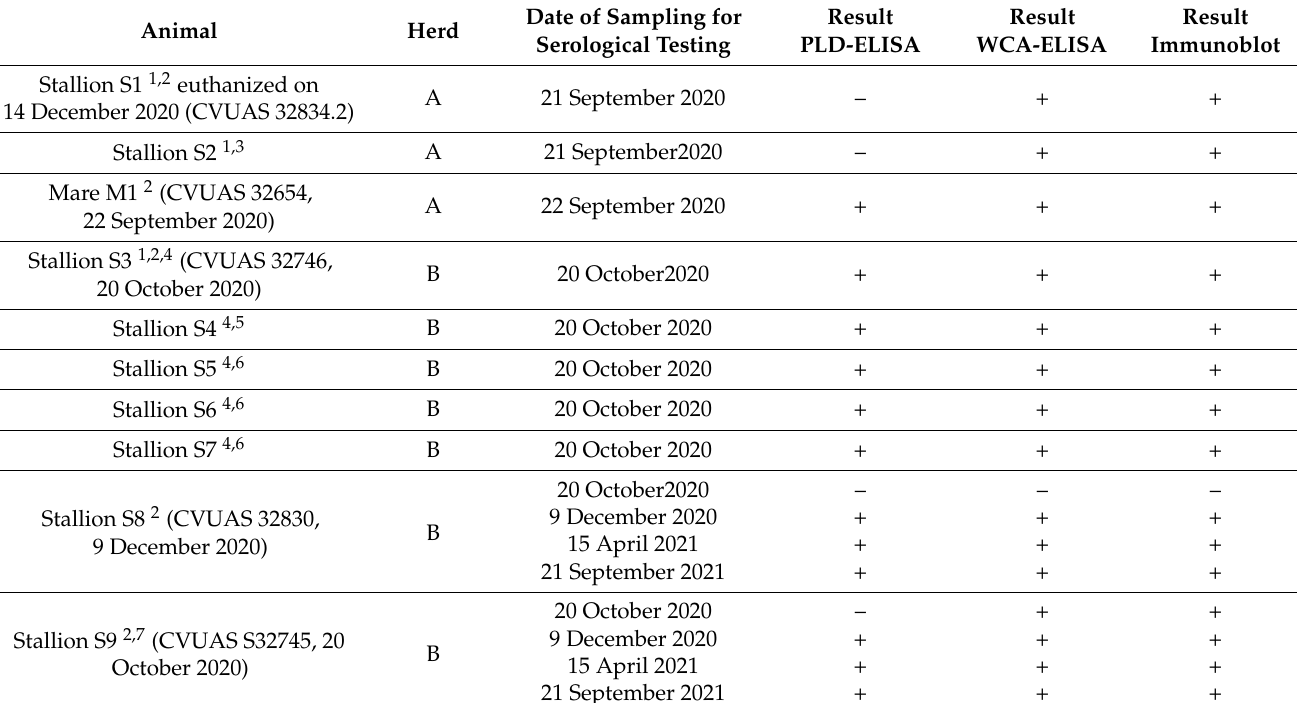
given in brackets in the first